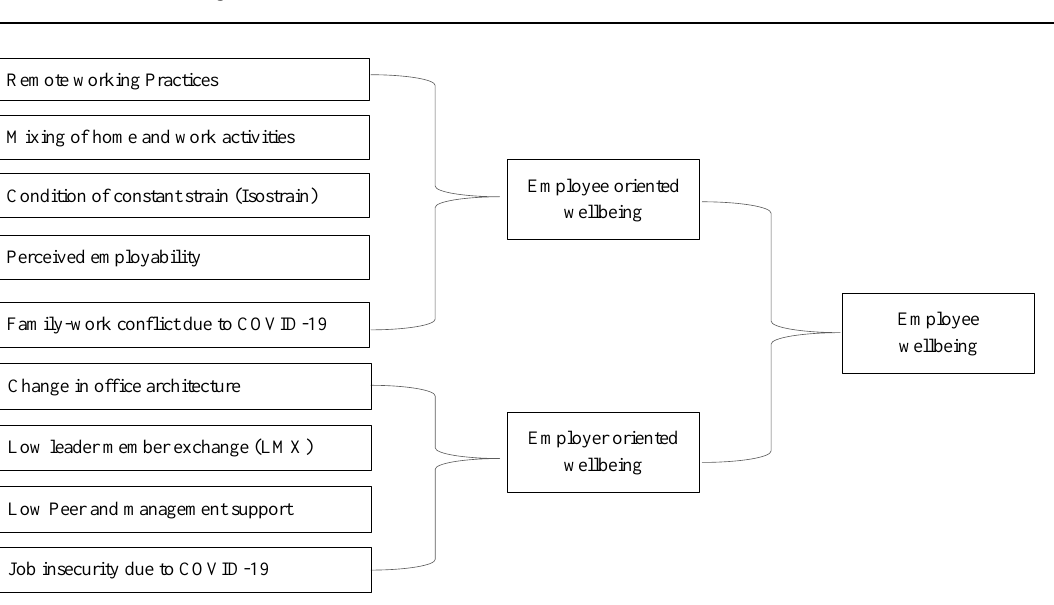
Figure 3: Categorization of data in sub-themes and themes